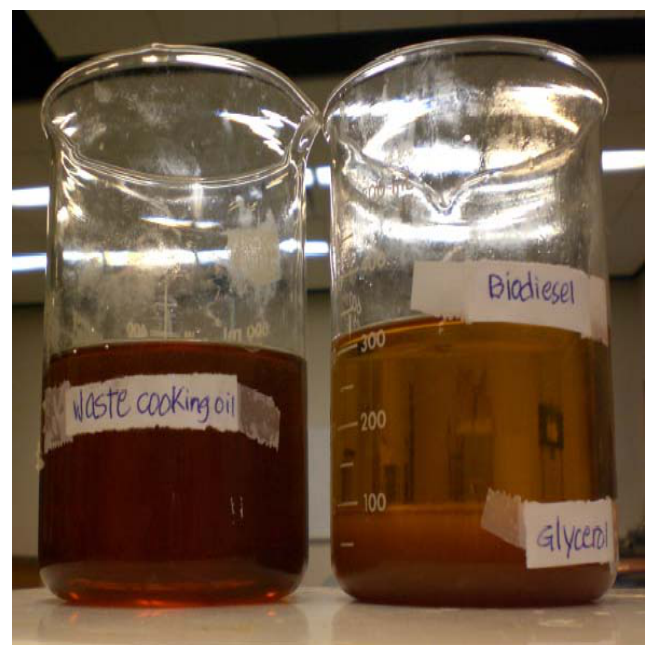
Figure 6. Biodiesel ester and glycerin